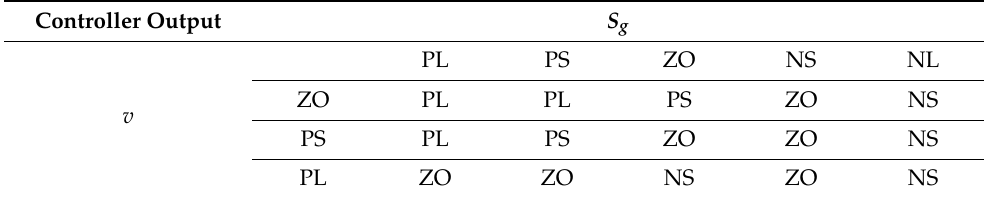
Table 7. Fuzzy rule base (with user’s posture; f f = M, f d = M).